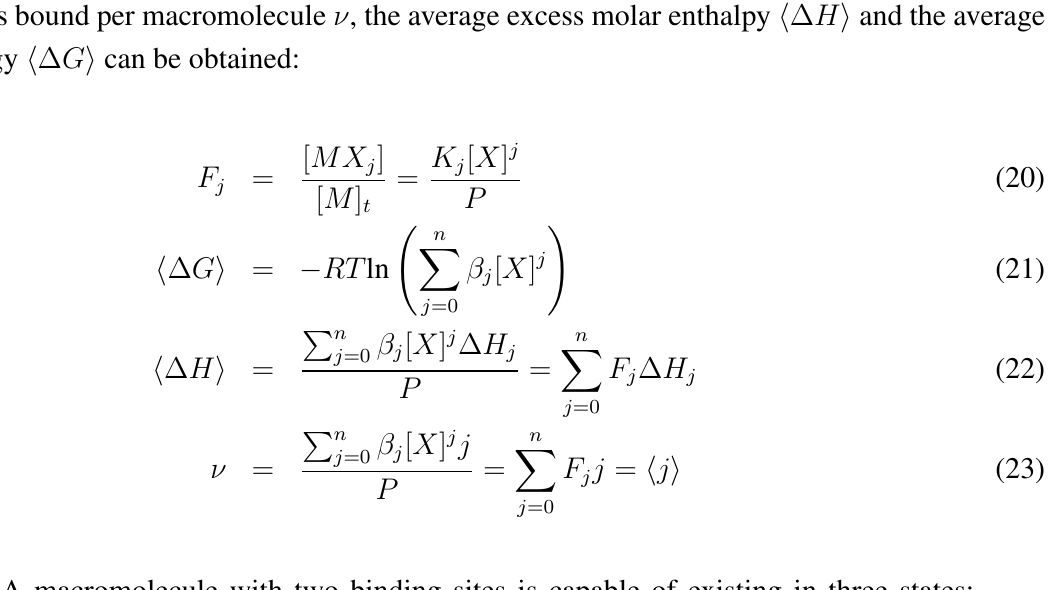
Table 1. A macromolecule with two binding sites is capable of existing in three states: unbound, singly bound or doubly bound. The relative concentration of these states depends on whether the macromolecular binding sites are identical and whether they are